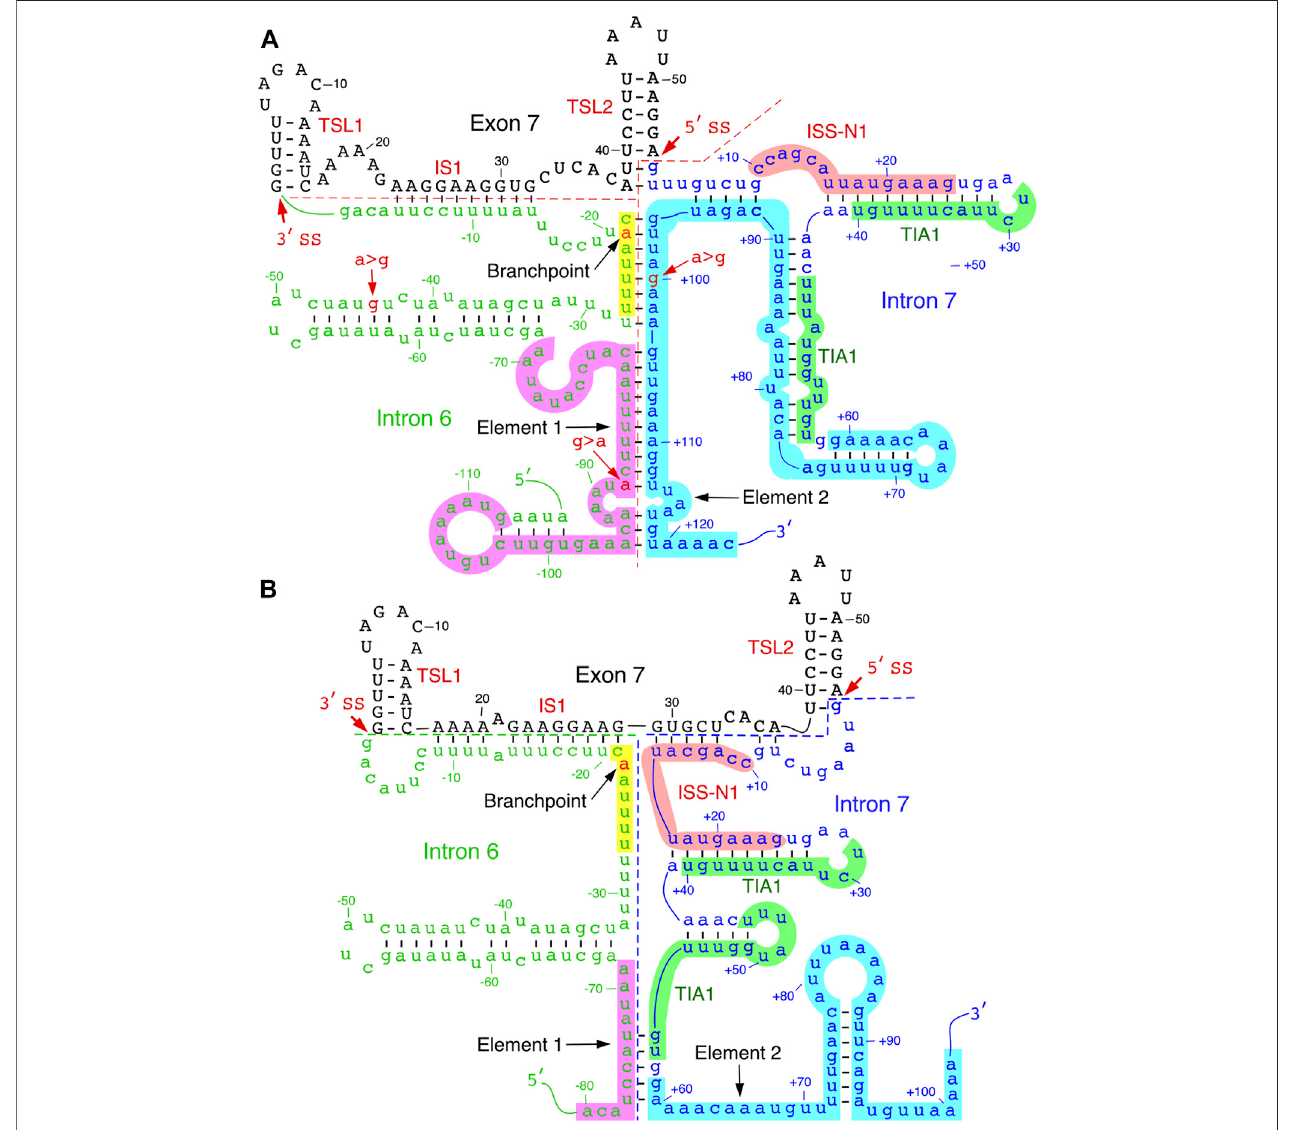
FIGURE 4 | Predicted inter-intronic structures. (A). Secondary structure formed between elements 1 and 2 located within introns 6 and 7, respectively. The structuresequestersbothTIA1bindingsites.Numberingofnucleotides,negative,neutralandnegative,startsfromthelastpositionofintron6, fi rstpositionofexon7and the fi rstpositionofintron7,respectively.Element 1ishighlightedinpurple;branchpointsequence, inyellow,with “ A ” indicatedinred.Othermarkingsandabbreviations are same as shown in Figure 3 . (B). An alternative secondary structure of element 2. The structural context changes the positioning of the TIA1 binding sites. Markings and abbreviation are the same as in panel